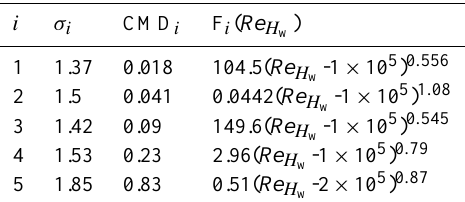
Table 1. Lognormal parameters for the SSSF parameterization. For each mode, a geometric standard deviation ( σ i ), count-median di- ameter (CMD i ), and the total number flux ( F i ) as a function of Reynolds number ( Re H ) are w